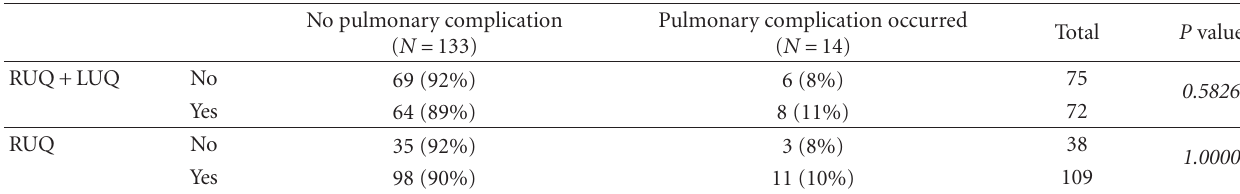
LUQ:left upper quadrant, RUQ:right upper